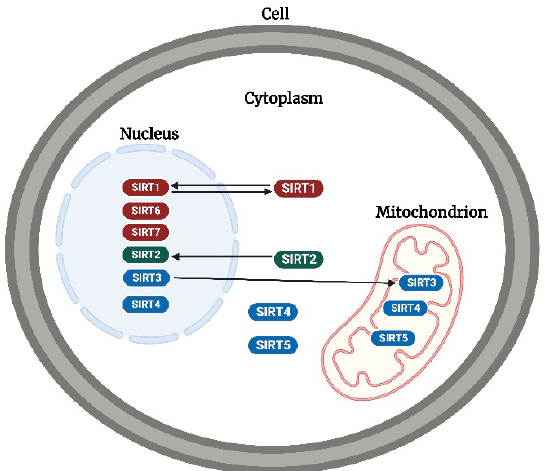
Figure 2. Subcellular location of sirtuins. SIRT1, 6, and 7 (in red), SIRT2 (in green), and SIRT3, 4, and 5 (in blue) are predominantly located in the nucleus, cytoplasm, and mitochondrion, respectively. SIRT1, 2, and 3 can translocate to the cytoplasm, nucleus, and mitochondrion, respectively. While SIRT 3 and 5 have been detected in the nucleus and cytoplasm, respectively, SIRT4 has been detected in both the cytoplasm and nucleus. The image was created with BioRender.com.